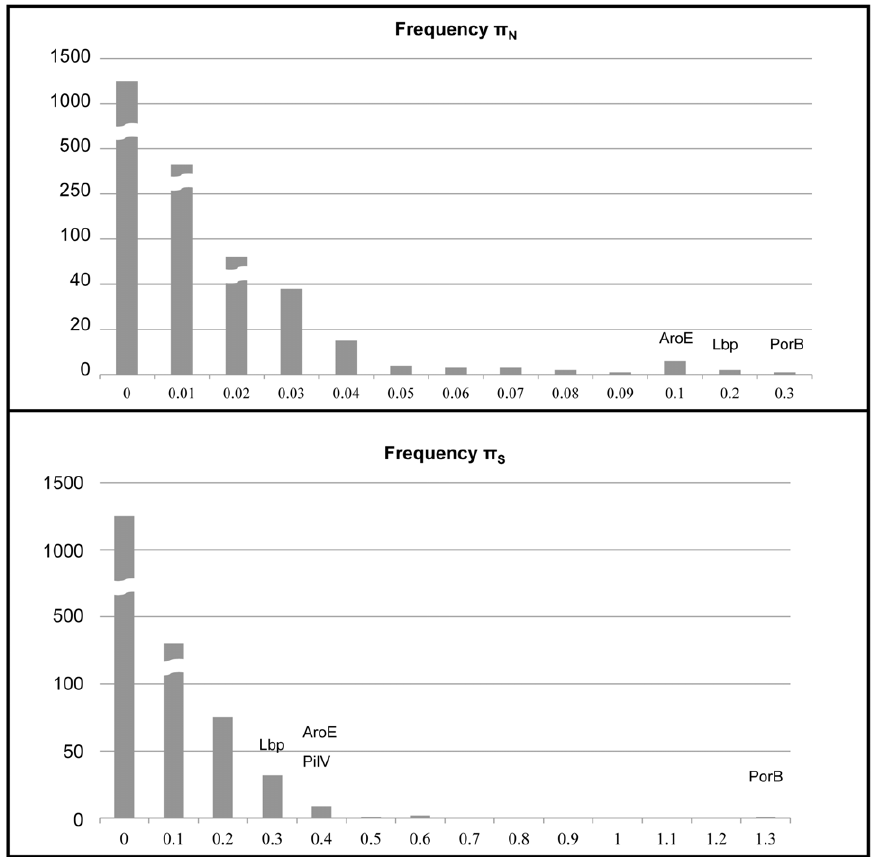
Figure 3. Histograms showing p N (number of non-synonymous substitutions per non-synonymous site) and p S (number of synonymous substitutions per synonymous site) in early strain type and late strain type genomes. p N and p S calculated using codeml from the PAML package.